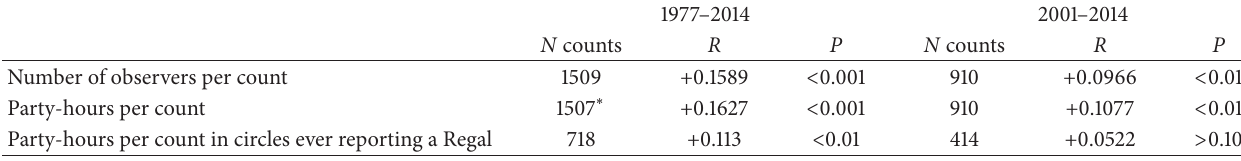
Table 1: Spearman rank correlations of measures of count effort with year (trend over time) in core Regal range.